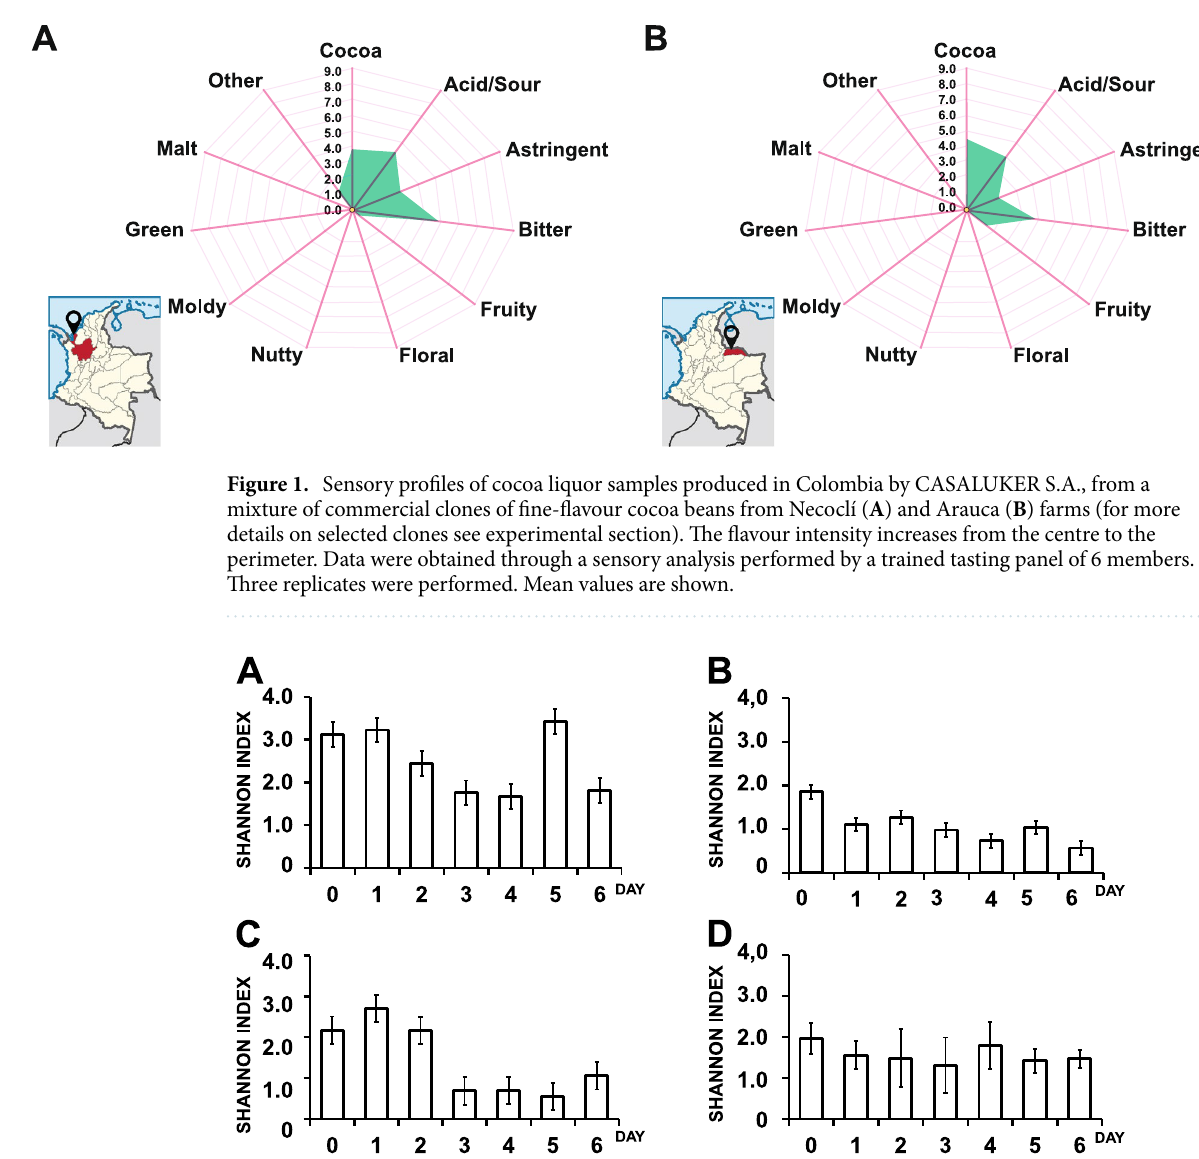
Figure 2. Changes in the Shannon Diversity Index during the fermentation of fine flavour cocoa beans at Necoclí ( A , B ) and Arauca ( C , D ) farms. Data is shown for bacteria ( A , C ) and fungi ( B , D ). Beans samples were collected every 24 h over fermentation as described in the methods